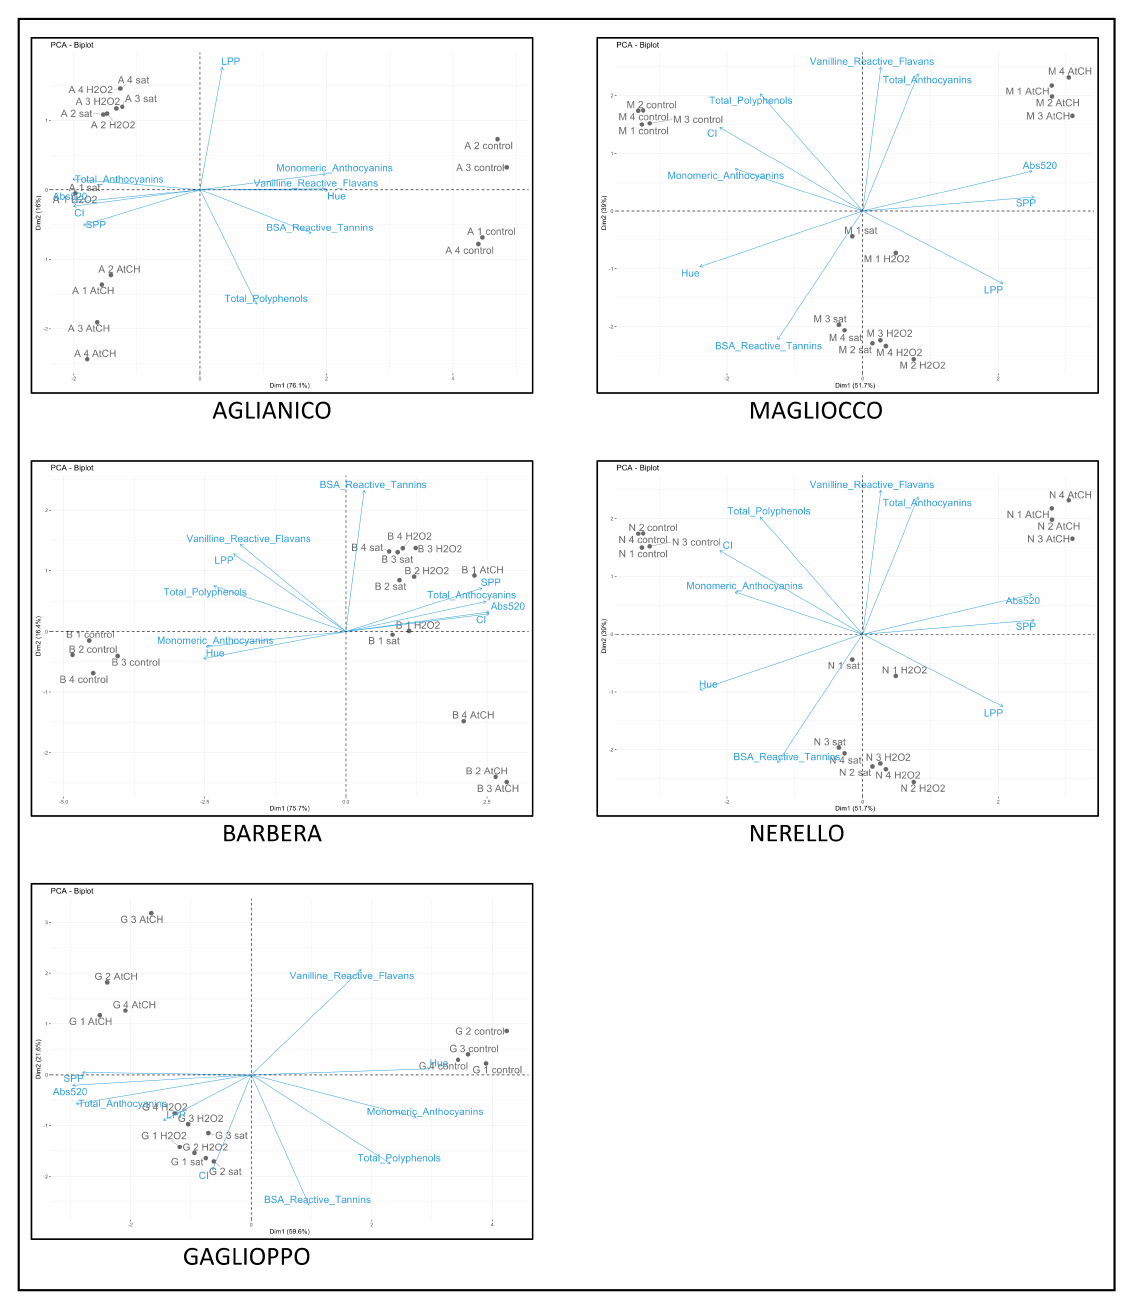
Figure 3. PCA score biplot of the first two PCs of data set of all phenolic compounds and chromatic characteristics in control and oxidized samples for each monovarietal wine (Aglianico, Barbera, Gaglioppo, Magliocco,